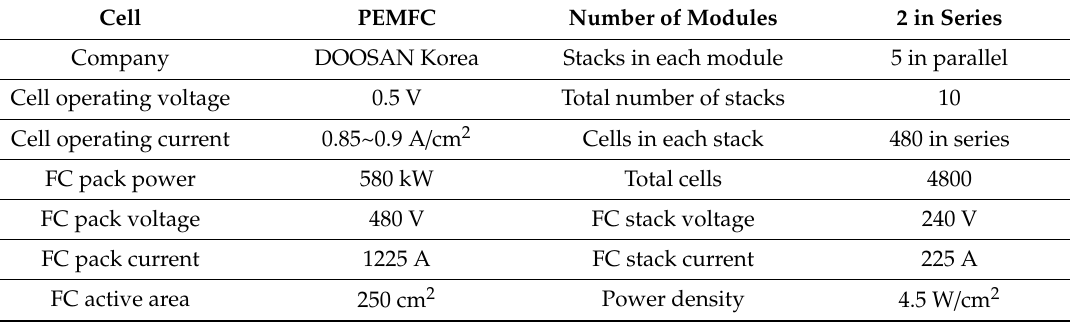
Figure 13. Load power distribution of actual load profile among power sources. Table 1. Configuration and specification of FC for hybridization with a battery.